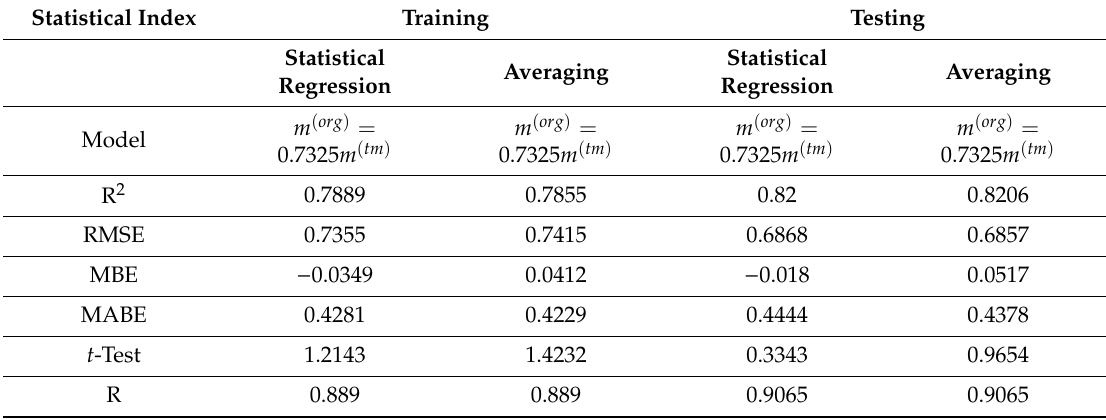
Table 3. The statistical indices of the regression and averaged models of organic MSW